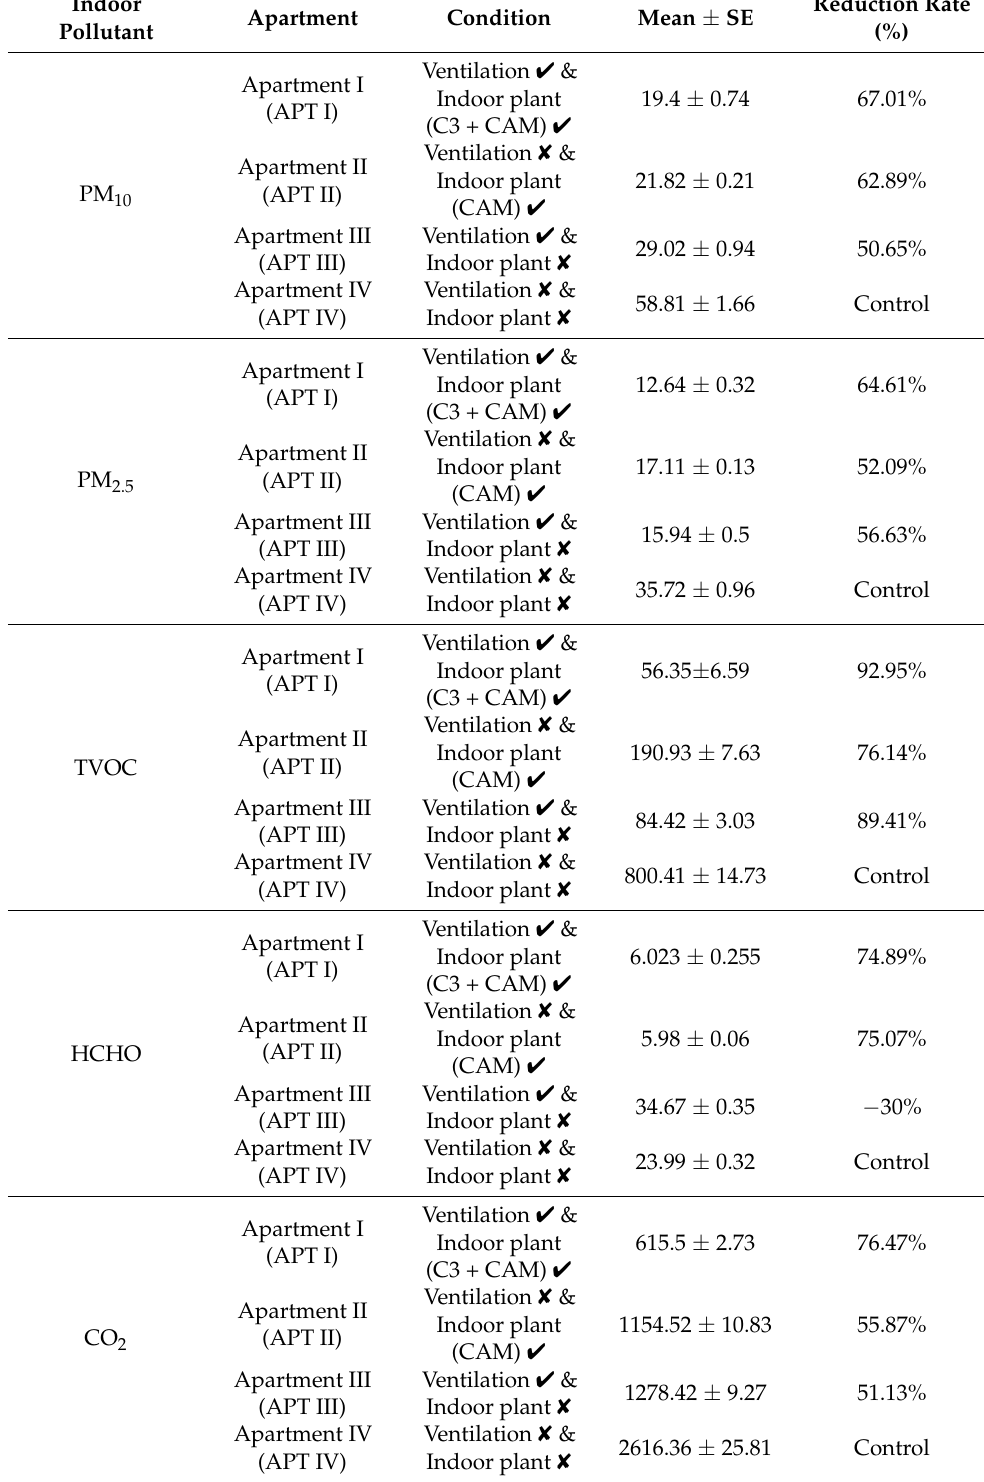
Table 3. Reduction Rate (%) of PM 10 , PM 2.5 , HCHO, TVOC, and CO 2 by indoor